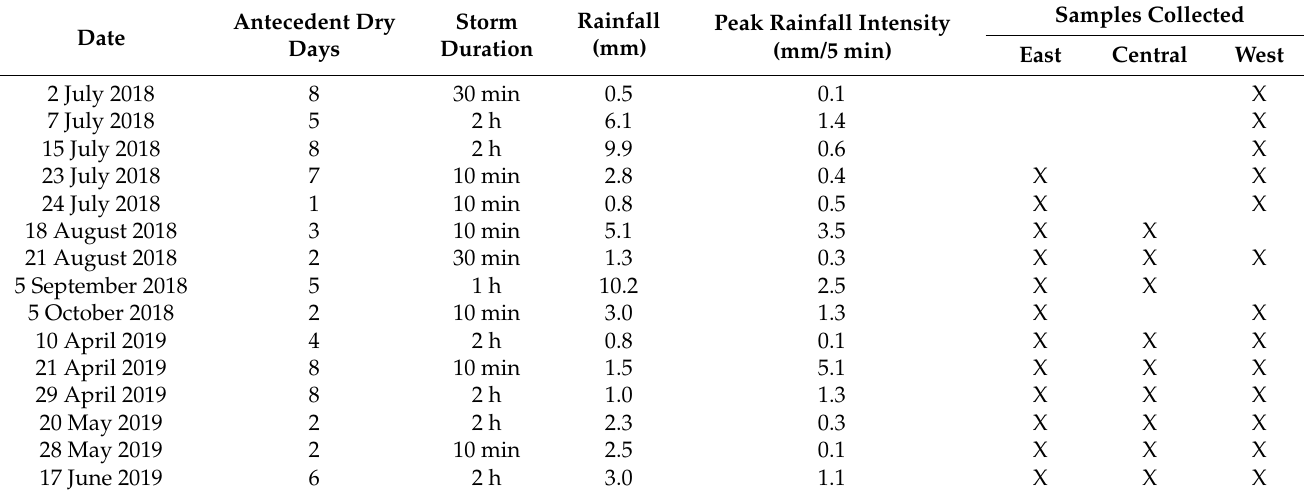
Table 6. Rain-event characteristics for each sampling